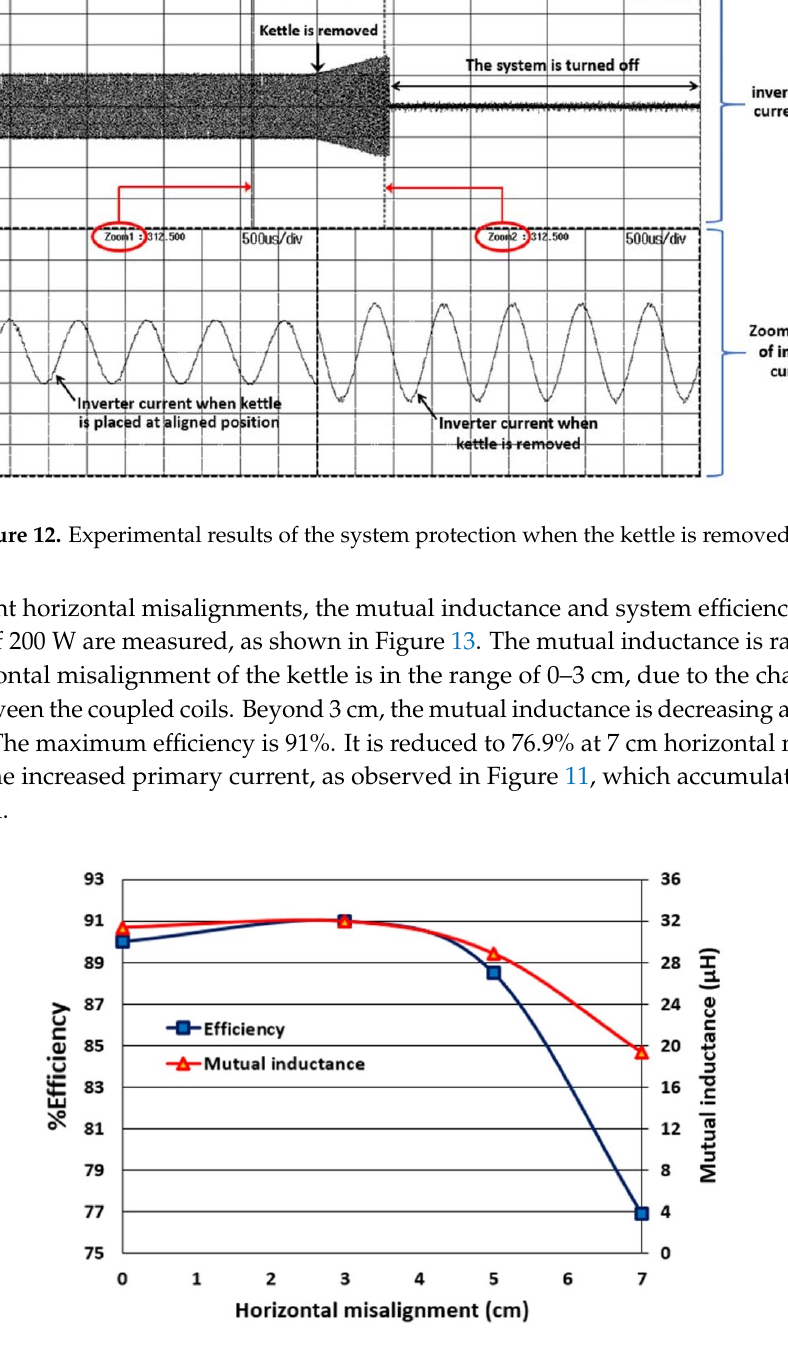
Figure 11. Experimental results of the output power regulation when kettle is moved 7 cm from aligned position.